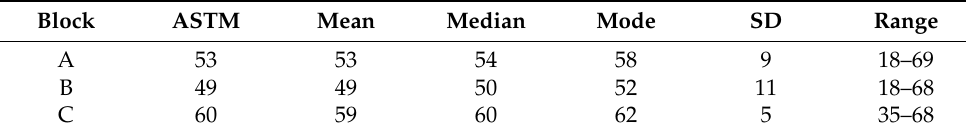
Table 2. Rebound number statistics of the assessed